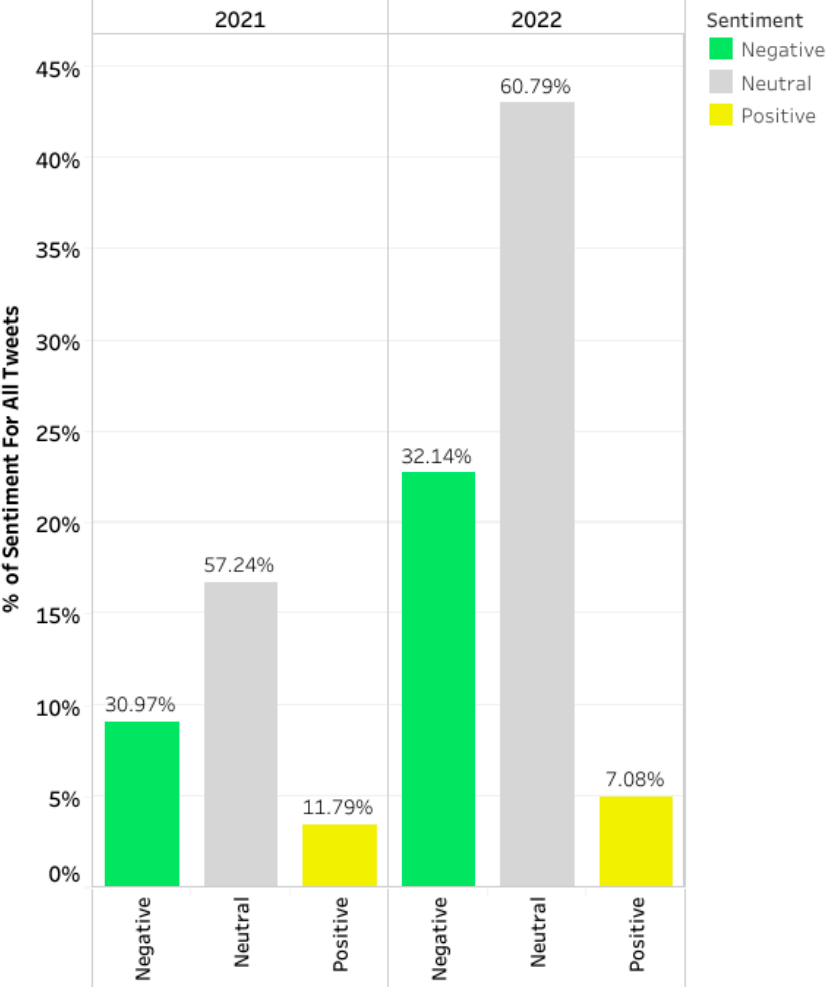
Figure A6. Sentiment among all keyword filtered tweets, 1 May–15 July 2021 vs. 2022. Percent changes in sentiment categories (negative, neutral, positive) between 2021 and 2022 were all statis- tically significant with p < 0.002.